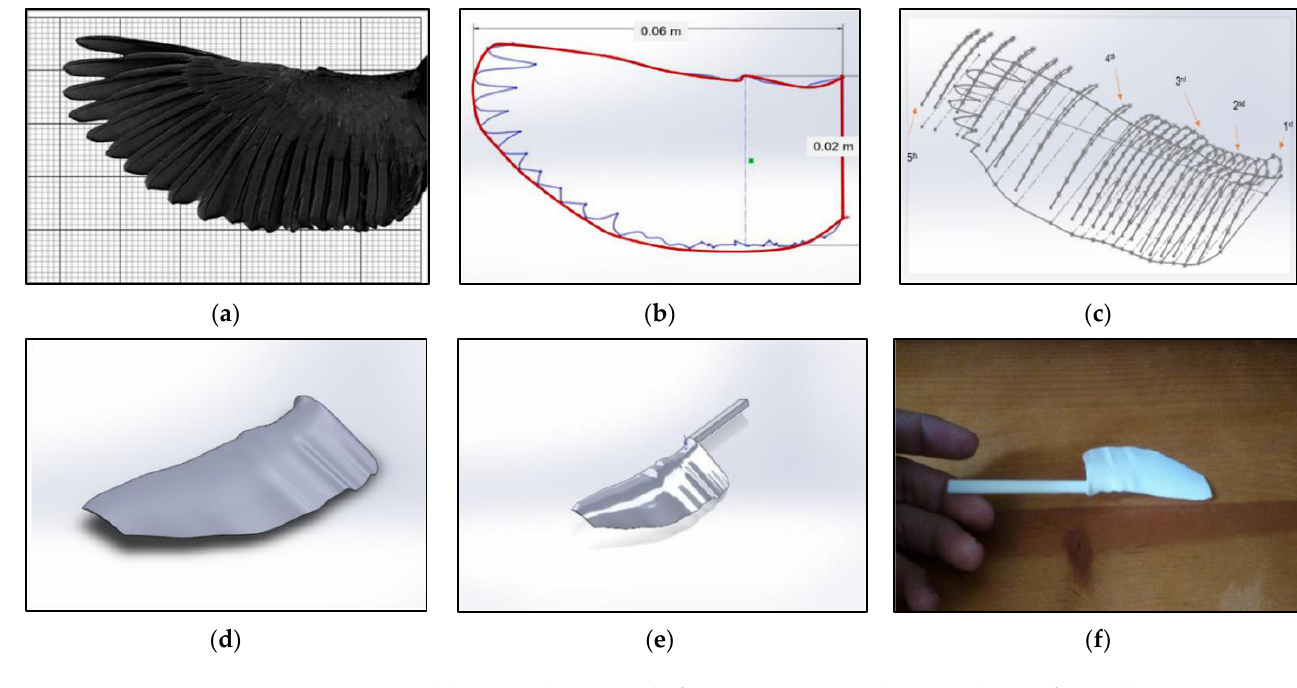
Figure 2. ( a ) Original wing ready for tracing process; ( b ) wing design after outline approximation; ( c ) framework of the profile-filling process; ( d ) and the finalized wing model; ( e ) complete corrugated (protrusion) CAD model; ( f ) 3D-printed wing model for experimental test rig. Table 1. Kingfisher-inspired wing model